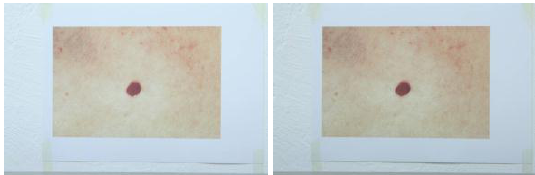
Figure 2. Medical test images#1 (a) SS: 2”5, AV:32, WB: AWB; (b) S S: 2”, AV: 32, WB: AWB